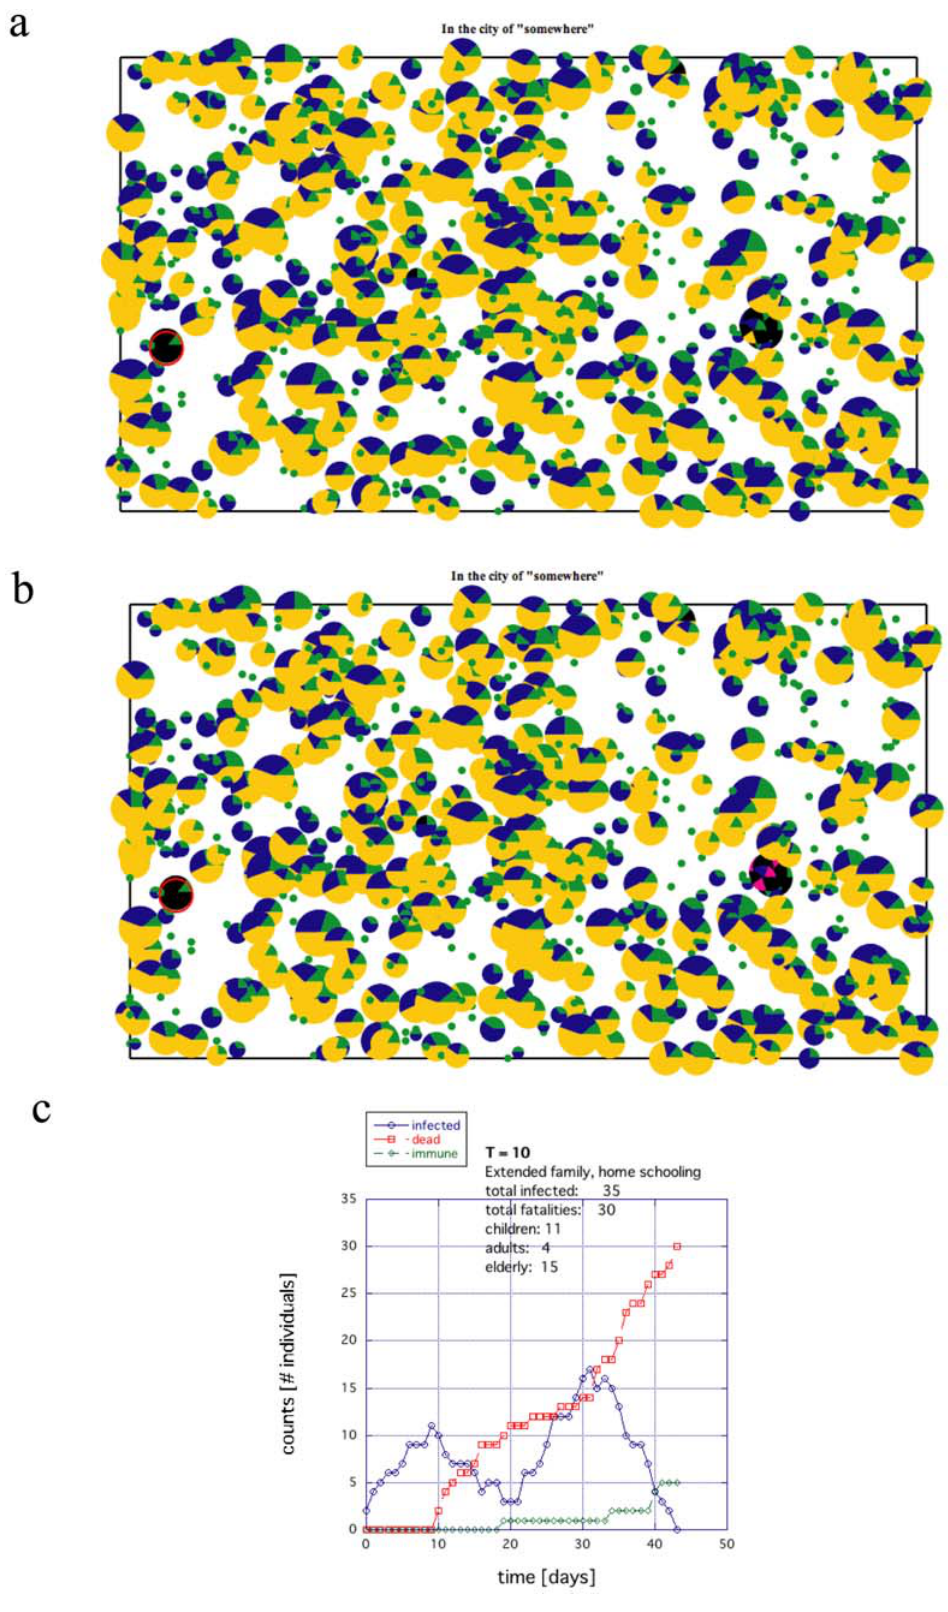
Figure 8. An example of the death toll for the same extended family society as in Figure 6 after home schooling is introduced (all other parameters held constant). (a) Surviving population whether infected or not where black indicates deceased. (b) Population of infected individuals both deceased (black) and recovered (magenta). (c) Time histogram of the rate of infection, death and recovery.